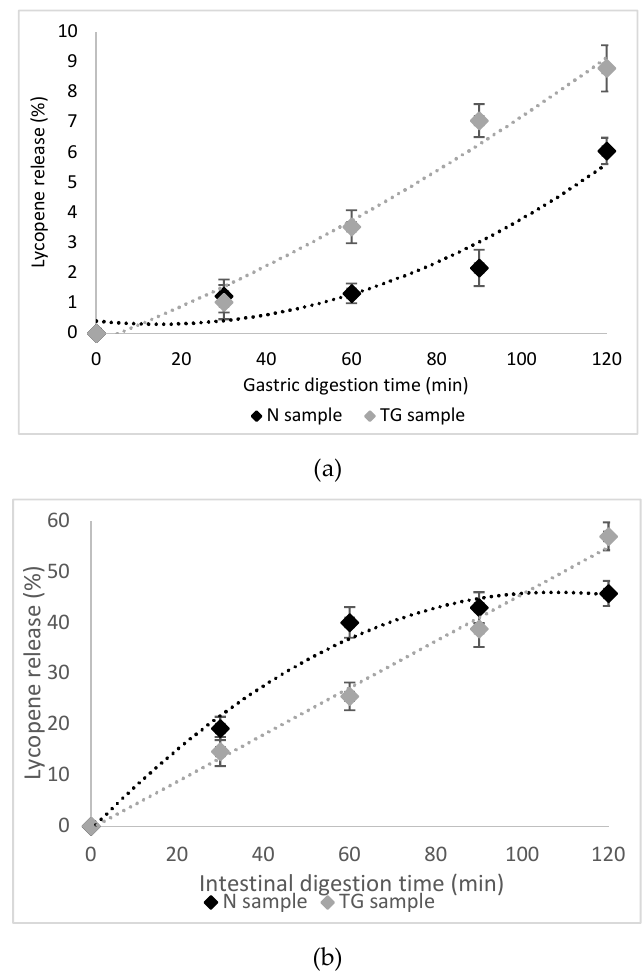
Figure 2. In vitro digestion of lycopene in simulated gastric ( a ) and intestinal ( b ) juices.